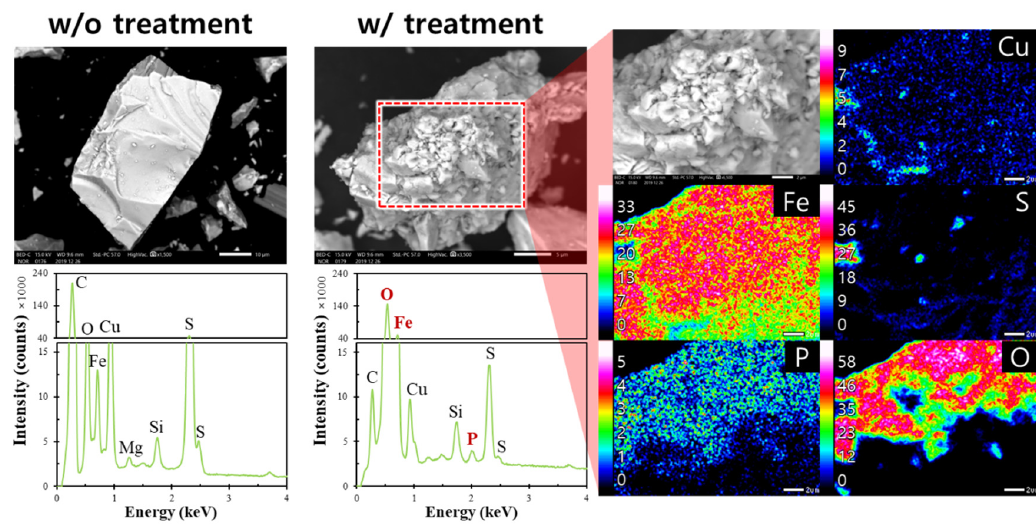
Figure 5. Scanning electron microscopy with energy-dispersive X-ray spectroscopy (SEM-EDX) results of chalcopyrite with and without microencapsulation treatment.